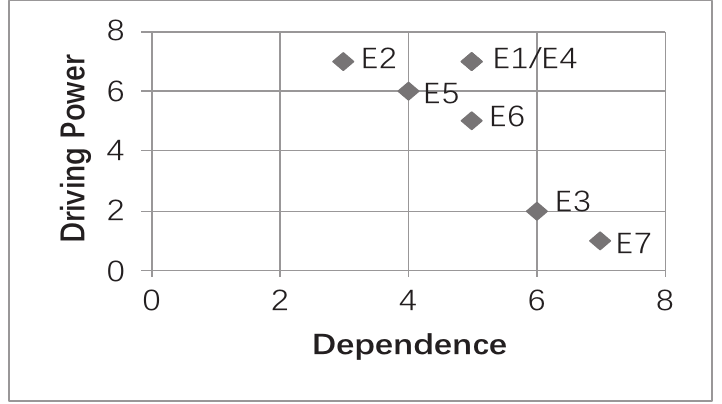
Figure 2. Level profile of enablers of